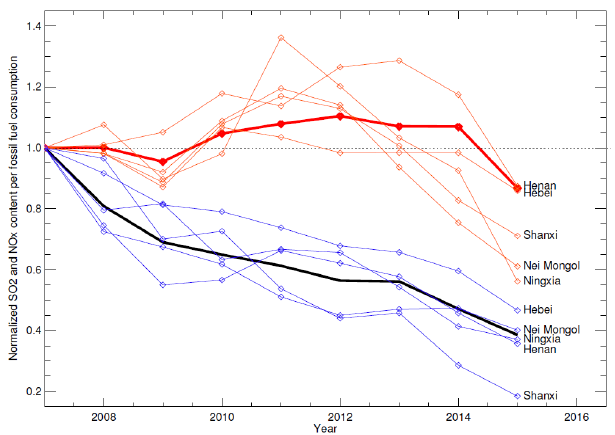
Figure 8. Same graph as Fig. 7 but with time series for the provinces Hebei, Henan, Nei Mongol, Ningxia, and Shanxi included. Time series per province of the ratio of the mean SO 2 columns and the fossil fuel consumption are drawn in blue. The ratios of the annual NO x emissions and the fossil fuel consumption per province are shown in red. All time series are normalized to the year 2007 and based on OMI